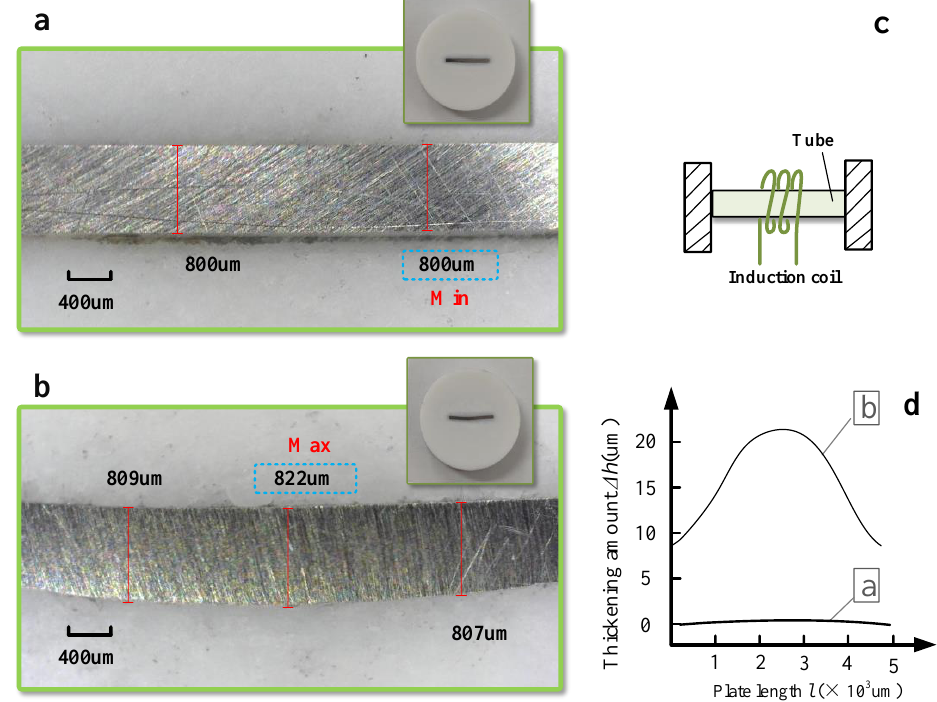
Figure 15. Comparison of thickening values between the two methods and tube forming: ( a ) tradi- tional method, ( b ) BPM, ( c ) BPM for tube forming and ( d ) thickening curve comparison.